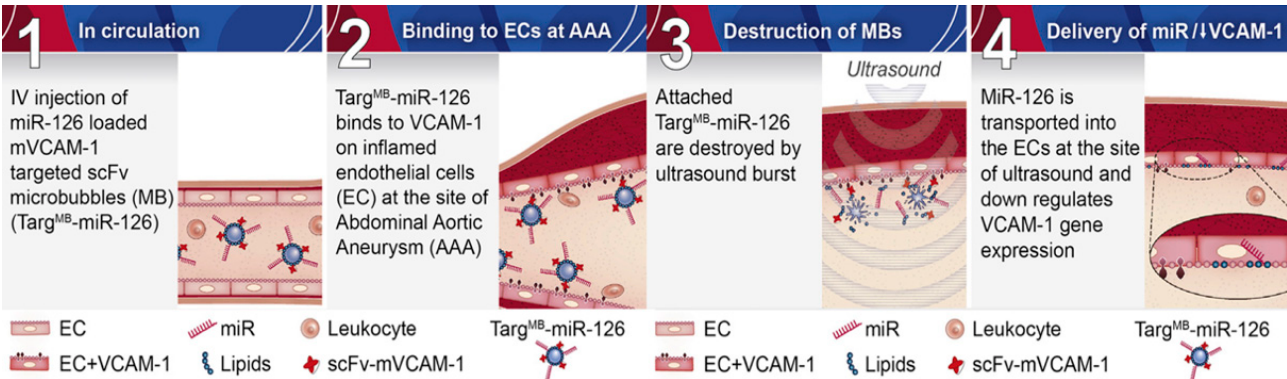
Figure 4. Demonstration of the theranostic TargMB-miRNA effect on VCAM-1 expression in AAA. Abbreviations: EC: endothelial cells; miRNA: microRNA; scFc-mVCAM-1: single-chain antibody targeting mouse VCAM-1; VCAM: vascular cell adhesion molecule-1. Adapted from Wang et al., [81] (open access article, distributed under the terms of the Creative Commons Attribution License).